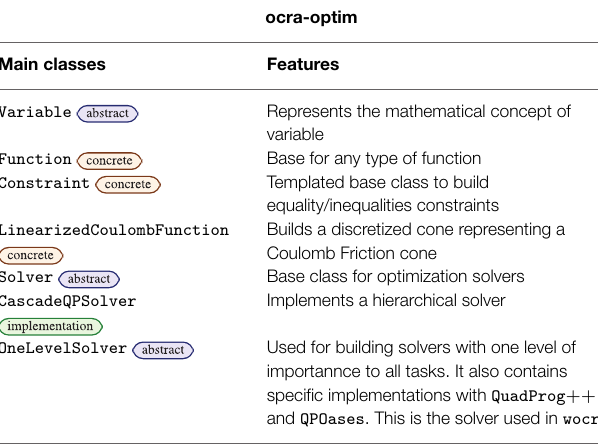
TABLE 6 | Main classes composing the ocra-coms library.